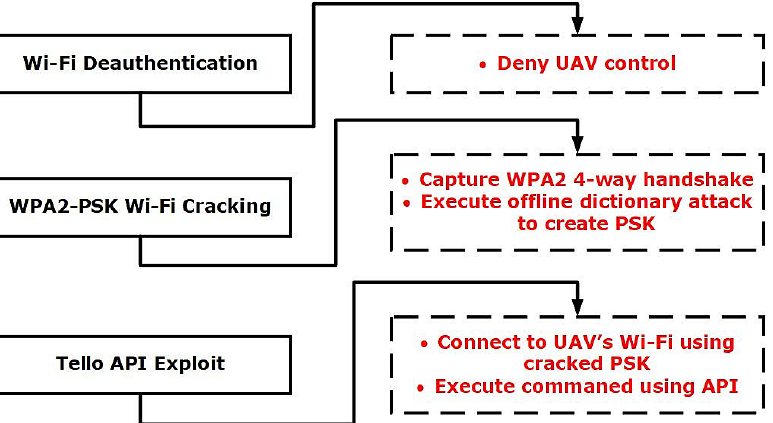
Figure 4. High-level Overview of Attack